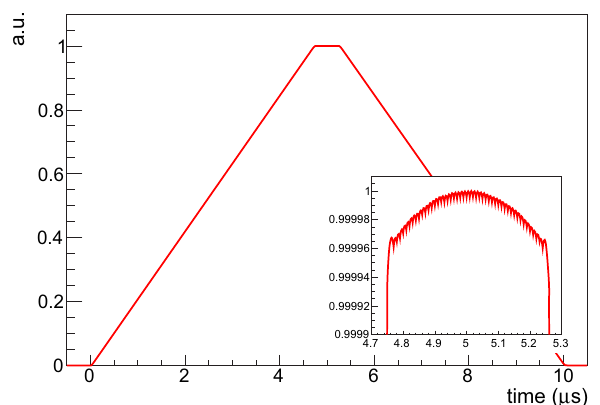
Fig. 4 The WF corresponding to the optimum FIR filter synthesized in case of series noise, under the assumptions of Eqs. (16), (21) and T max = 500 ns, showing that the automatically synthesized flat-top width matches the time distribution of the filter input signals